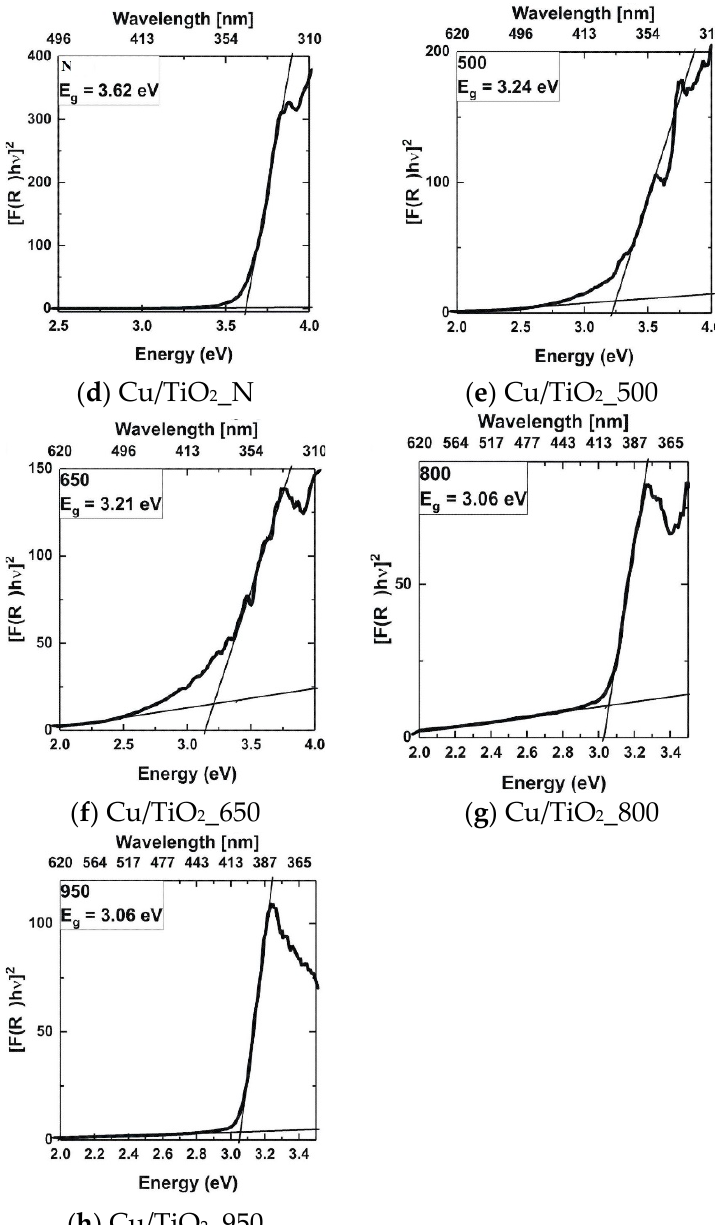
Figure 13. Diffuse reflectance spectra and band gaps for pristine TiO 2 , standard TiO 2 _P25, Cu/TiO 2 _500, Cu/TiO 2 _650, Cu/TiO 2 _800 and Cu/TiO 2